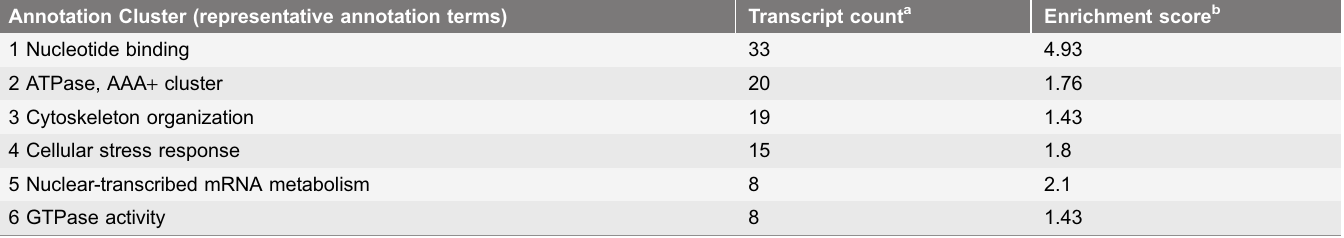
Table 2. DAVID functional annotation clusters of G. nigrifrons transcripts upregulated in transmitters and acquirers relative to non-acquirers and the healthy control. Annotation Cluster (representative annotation